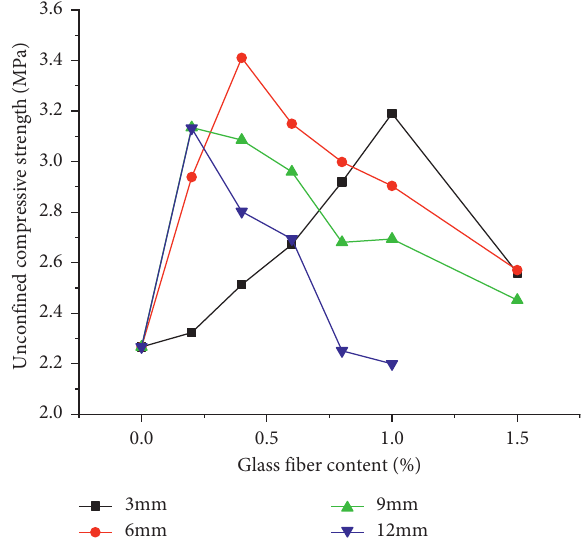
Figure 10: The relationship between unconfined compressive strength and glass fiber content.